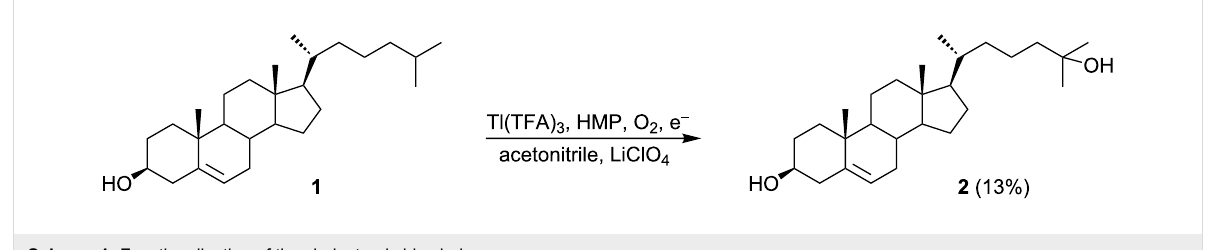
Scheme 1: Functionalization of the cholesterol side chain.